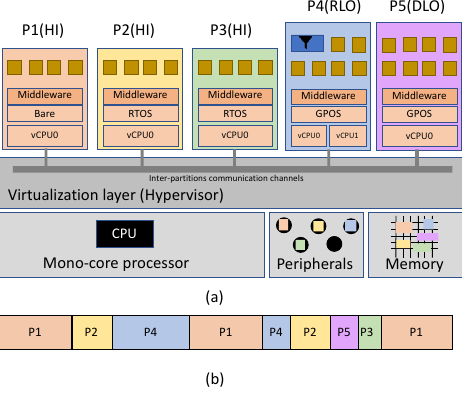
Figure 4. Example of a system with 5 partitions and different criticality levels. ( a ) architecture and ( b ) CPU allocation.